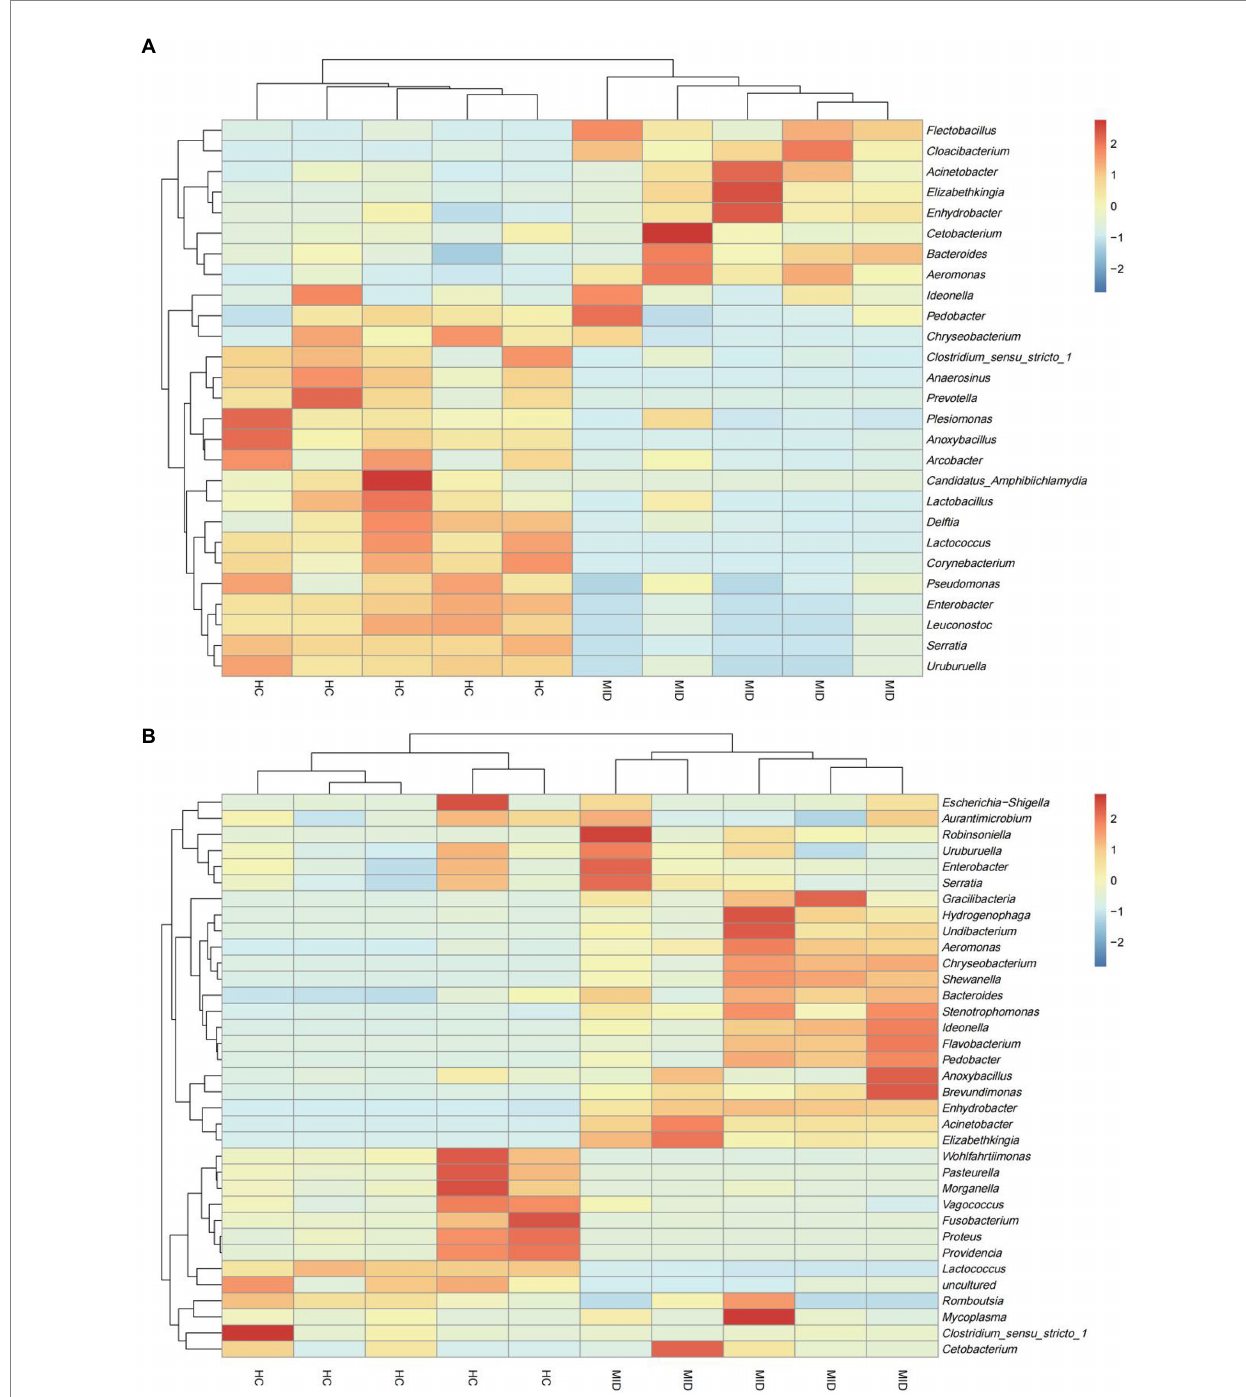
FIGURE 5 Heat map of the genus of top 35 microbiota in the HC and MID groups. Differences in relative abundance at genus level in different samples. Heat map showed the difference in annotated gene abundance at genus level among groups (showing the relative abundance of the top 35 genus). The row clustering distance method is Pearson correlation, and the default is Euclidean distance. Columns represent a sample and rows represent a genus. Based on the average relative abundance of the genus in the same sample, the expression level higher than the average value is positive and marked in red; on the contrary, the expression level below the average value is negative and marked in blue. The shade of color indicates the degree of difference between the relative abundance and the mean. The dendrogram above the main body of the heatmap clusters the source of the samples, which is convenient for distinguishing different samples (normal and diseased); the dendrogram on the left of the heatmap clusters the relative abundance of genera, and groups the genera with similar relative abundance to For one class, the color difference is more pronounced. In the gut (A) , genera with high relative abundance were concentrated in the diseased group, and in the oral cavity (B) , genera with high relative abundance were concentrated in the normal